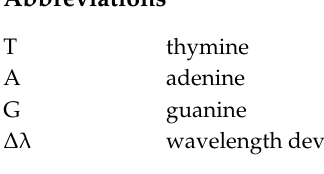
Supplementary Materials: The following are available online. Figure S1: Spectra obtained in the titrations of TMPyP with GQ and duplex DNA sequences, Figure S2. CD spectra obtained for GQ unimolecular in the presence and absence of ZnPc1 and ZnPc4, Figure S3. CD spectra obtained for the duplex oligonucleotide 5GC in the presence and absence of ZnPc1 and ZnPc4, Table S1: Spectra obtained in the titrations of TMPyP with the different DNA sequences, Table S2: Band maxims for ligands in different solvents and solutions, Table S3: Obtained molar extinction coefficients and band maximum for ligands; list of